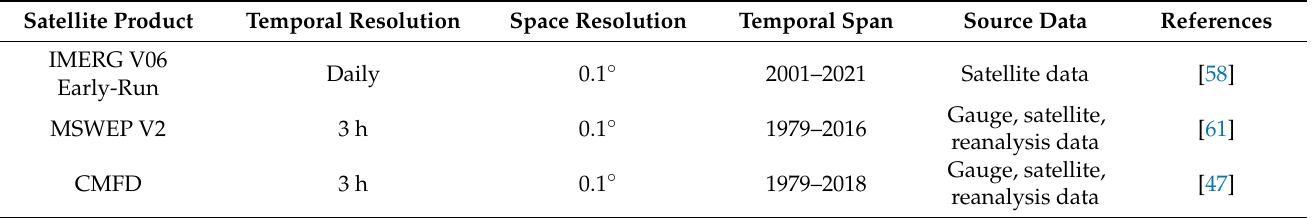
Table 1. Summary information for the three satellite-derived precipitation products used in this